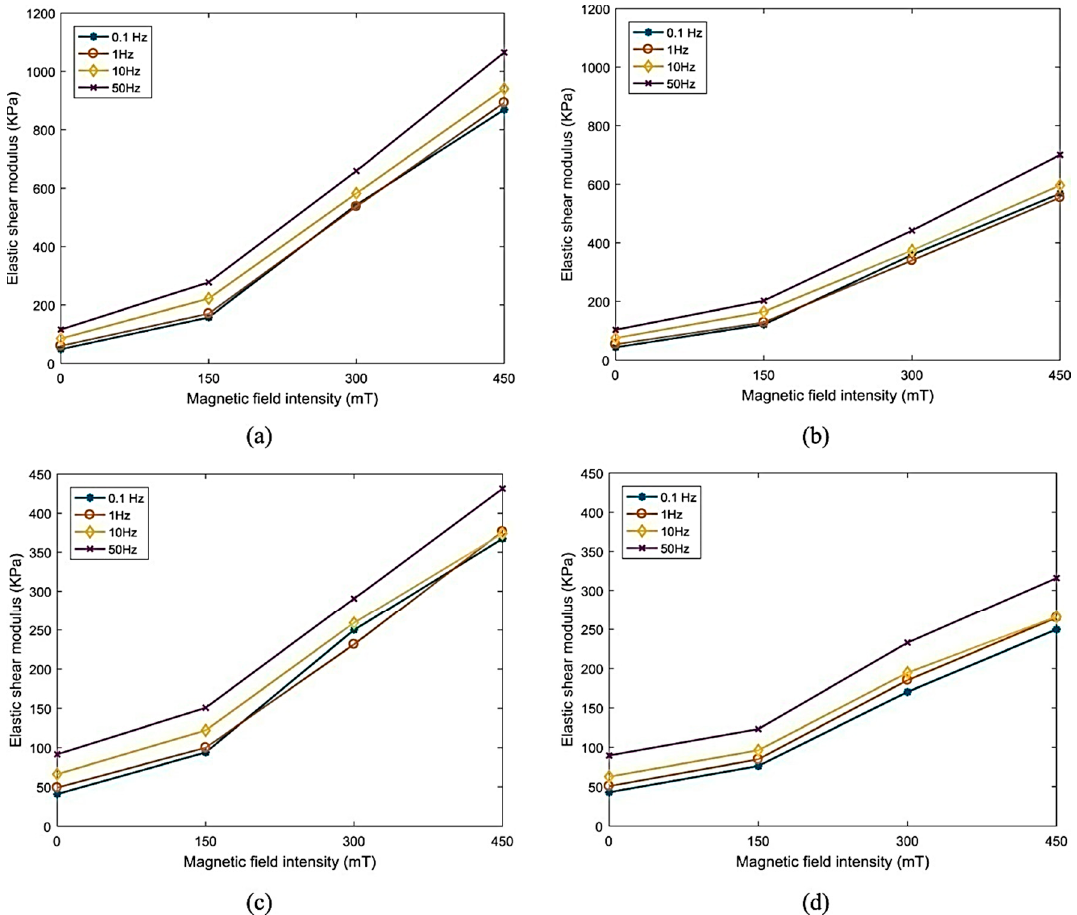
Figure 12. Impact of magnetic flux density on elastic shear modulus under various strain amplitudes and various excitation frequencies: ( a ) 2.5%, ( b ) 5%, ( c ) 10%, ( d ) 20% [95] (reprinted with permission from Elsevier TM ).